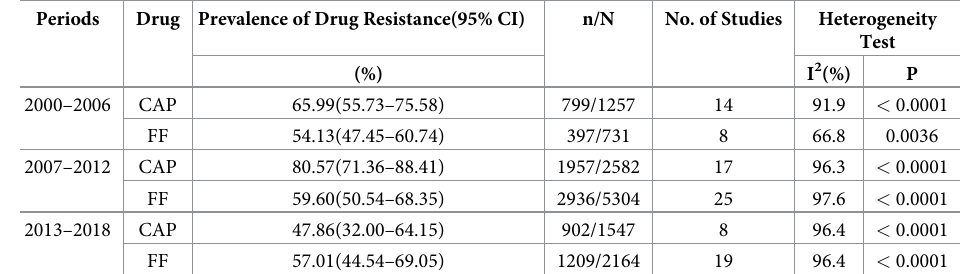
Table 3. The prevalence of the Chloramphenicol/Florfenicol resistance during the different periods.